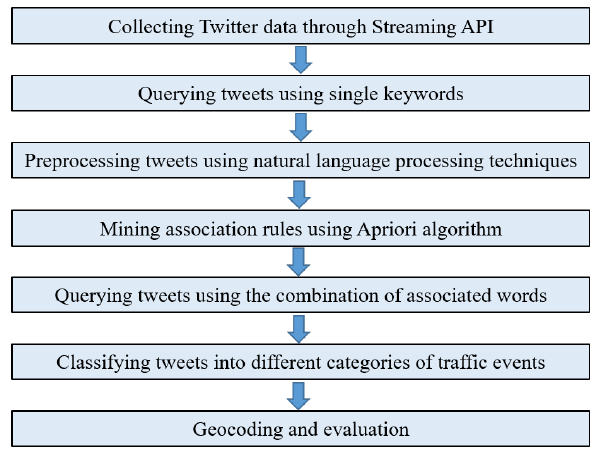
Figure 1. The overall workflow of detecting traffic events using geosocial media